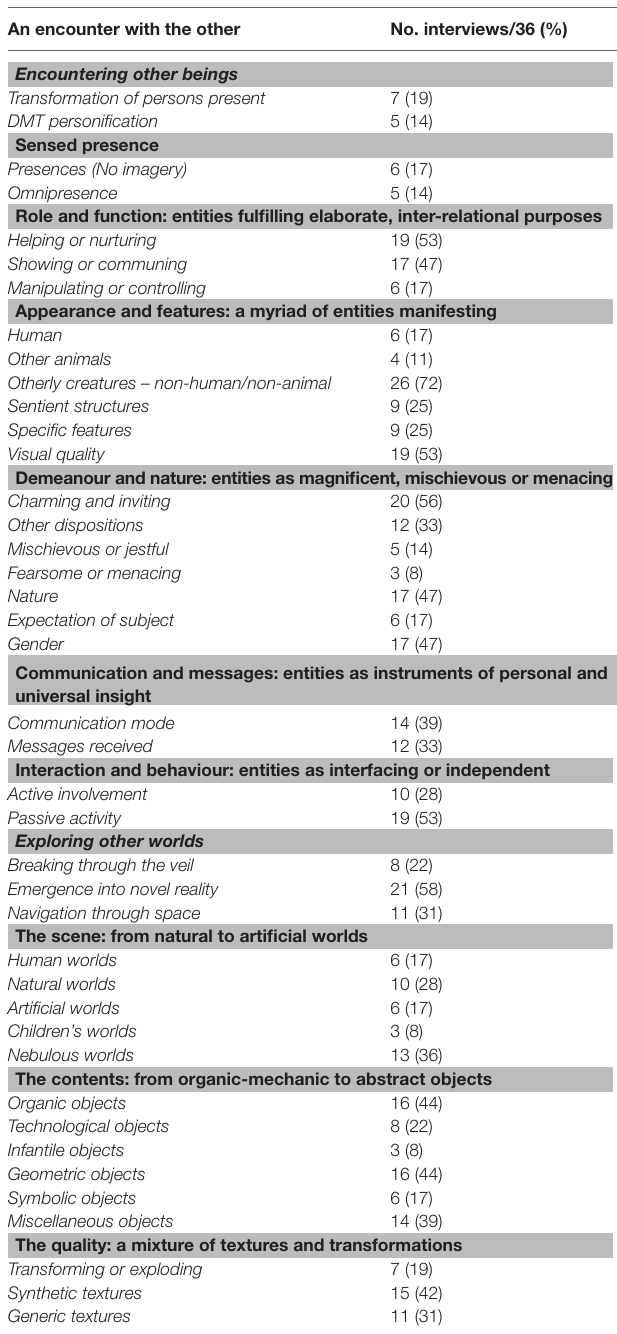
TABLE 2 | Thematic analysis of the DMT experience: an encounter with the other; tabularisation of categories, super-ordinate and mid-level themes explored in the present article – see Supplementary Table 3 for list of all